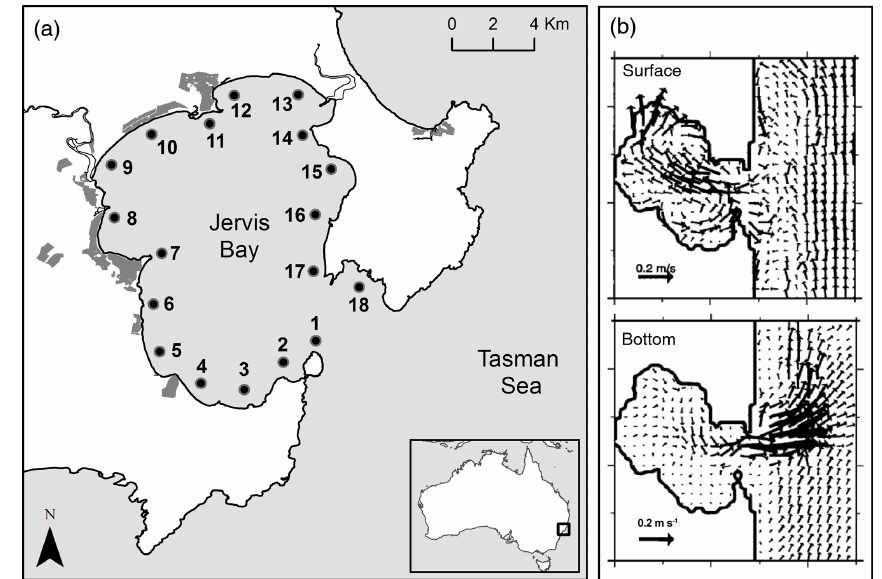
Figure 1. (a) Map of Jervis Bay (south-eastern Australia). Black dots show the seeding locations and also the centre of destination regions used in the coastal connectivity analysis. Shaded areas represent urban zones. (b) Typical surface and bottom currents of the bay (modified from Wang and Symonds,